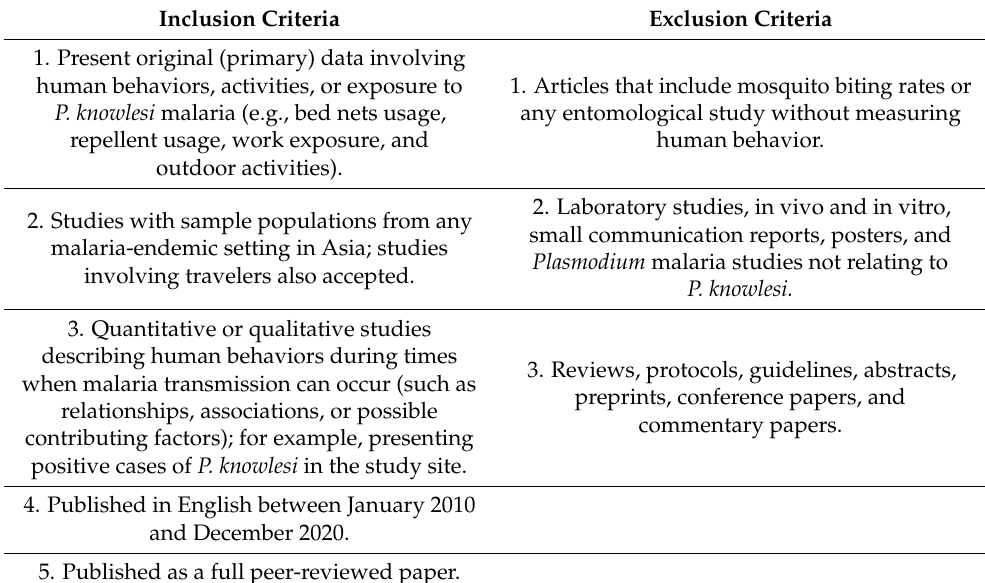
Table 1. Inclusion and exclusion criteria for